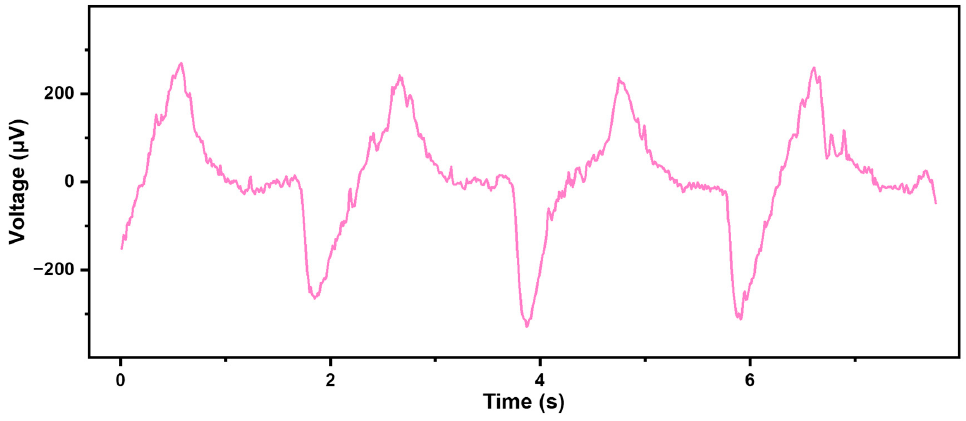
Figure 8. EEG signal recorded with NEH self-adhesive electrode after 3 days. Motions (such as movement, shake, and even vibration) commonly disturb the ac- quisition of biosignals to get distorted baselines and waves [38,39]. To verify the anti-in- terference ability of the NEH self-adhesive electrode, we collected the ECG signals under wrist motion disturbances (Figure 9). We placed the NEH self-adhesive electrode on the inside of the right wrist. GND electrode and Ref electrode (CEP) were placed on the back of the left wrist and the back of the left hand. The subject performed four actions as com- manded: static (T1), bending arm at 0.1 Hz (T2), static (T3), and bending arm at 0.2 Hz (T4). The subject bent the right arm 90° in his direction, uniformly keeping his left arm still. Figure 9a shows the results of the CEP and Figure 9b shows the results of the NEH